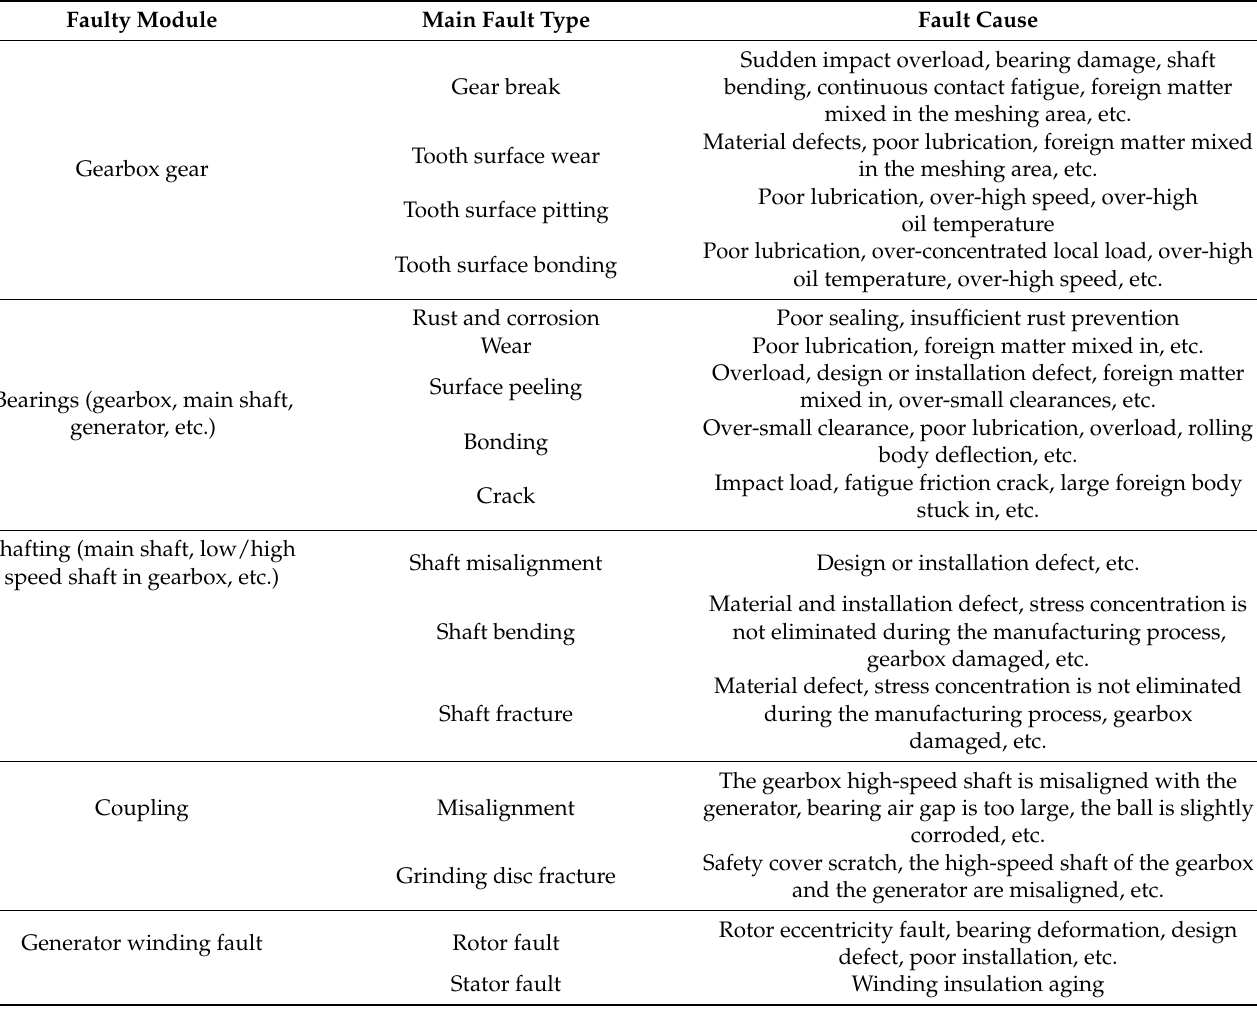
Table 1. Types and causes of typical faults of main drive chain in wind